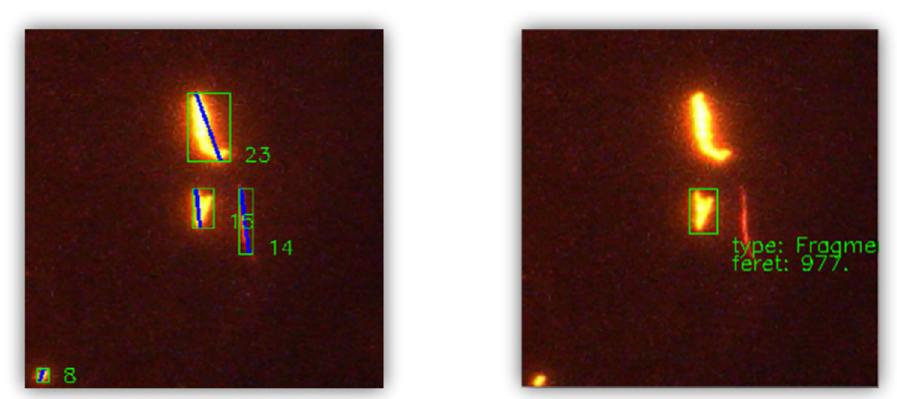
Fig 12. Representative patches illustrating MP visualization in